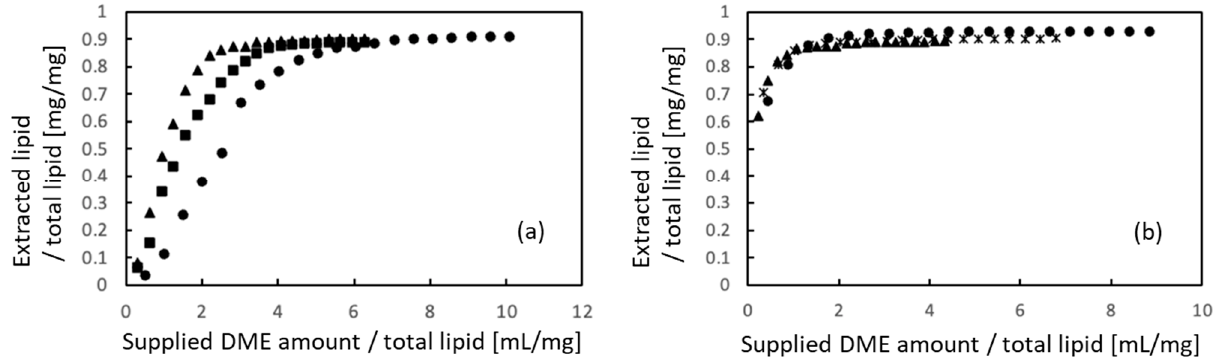
Figure 3. Lipid extraction from porcine auricular cartilage using liquefied DME. ( a ) 10 × 10 × 1 mm samples, ( b ) 710–1000 µm-sized samples. The three symbols represent individual differences among three samples.